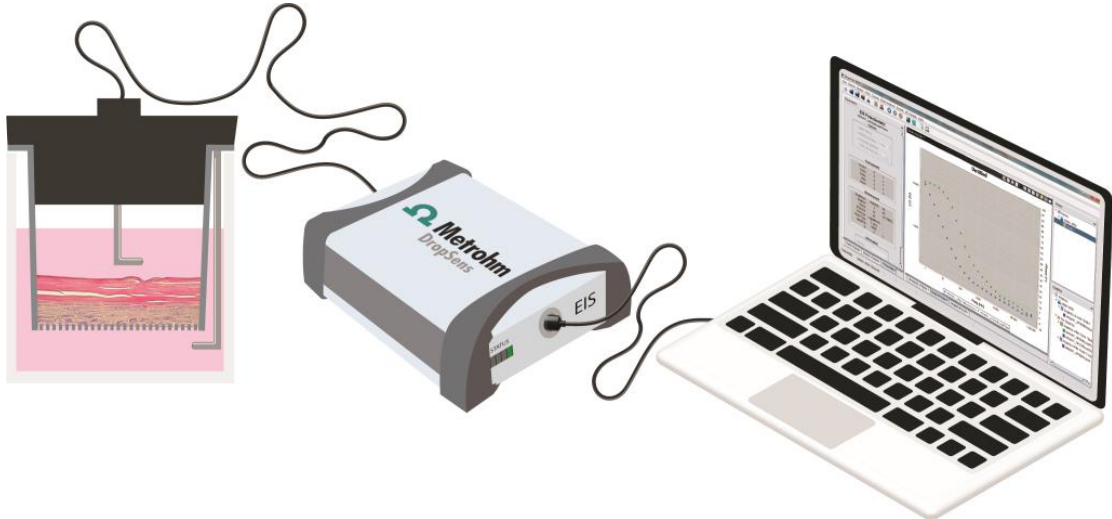
Figure 1. Experimental set-up for EIS analysis.